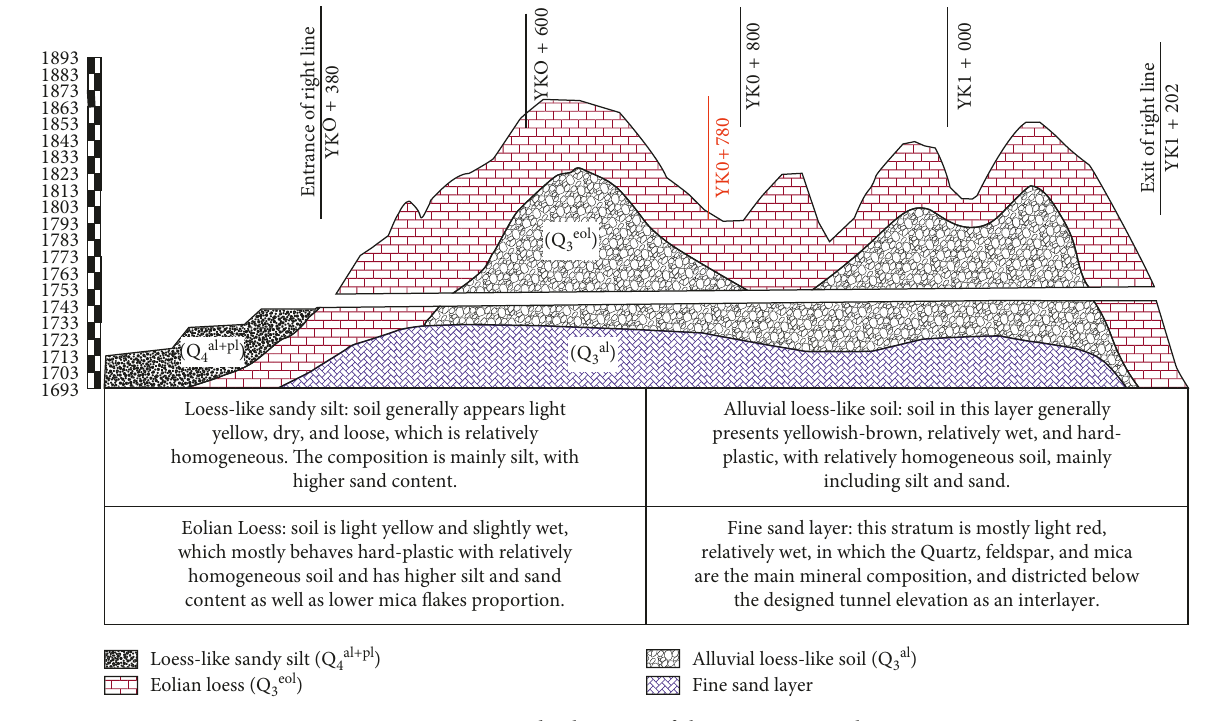
Figure 1: Longitudinal section of the Fujiayao tunnel.